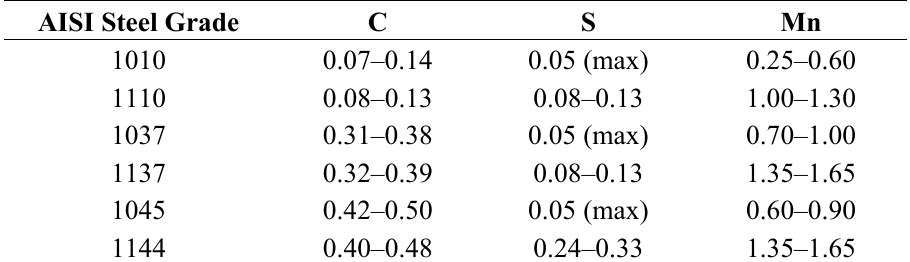
Table 5. Content of C, S and Mn in some common steel grades (wt.%)